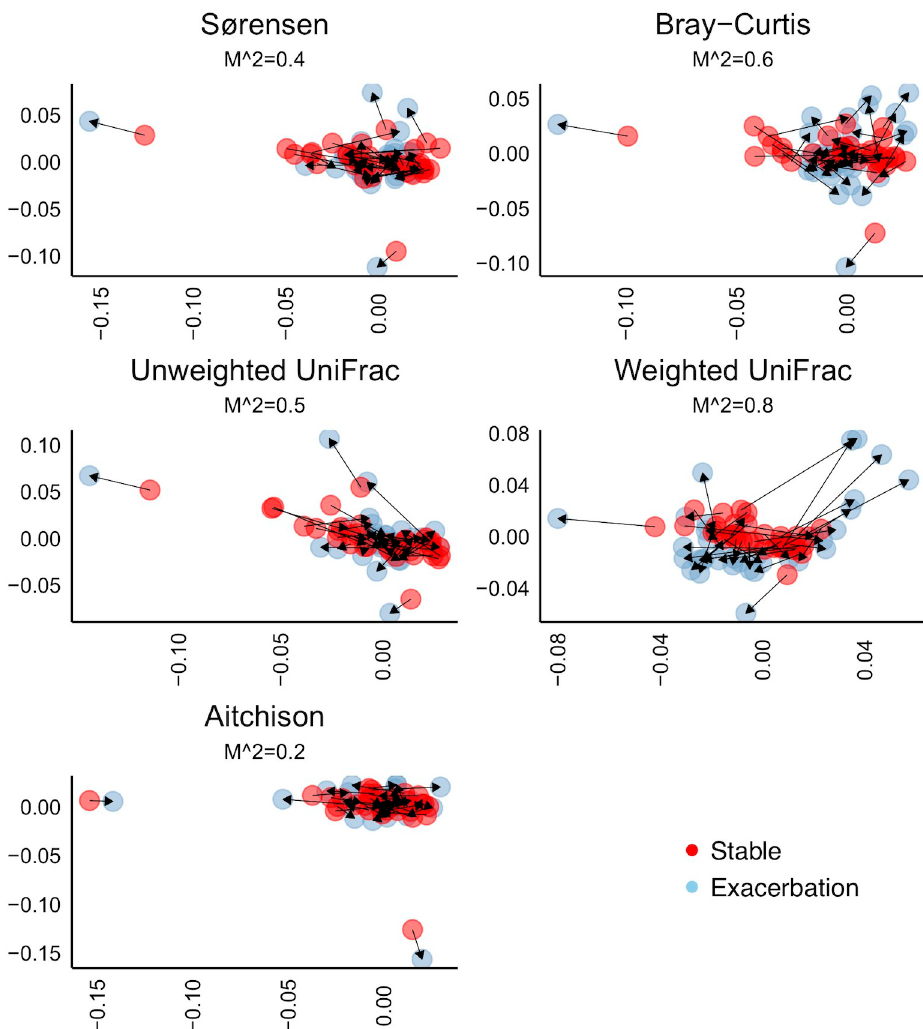
COPD. Distance matrices: S ø rensen and Bray Curtis: Both non-phylogenetic; qualitative and quantitative information respectively. Unweighted and weighted UniFrac: Both phylogenetic; qualitative and quantitative information respectively. Aitchison: Compositional interpretation of sequencing data. M^2 = Summed squares of distances. The significance of M^2 was tested for all comparisons, with p < 0.05 for all but WUF (PROTEST p =